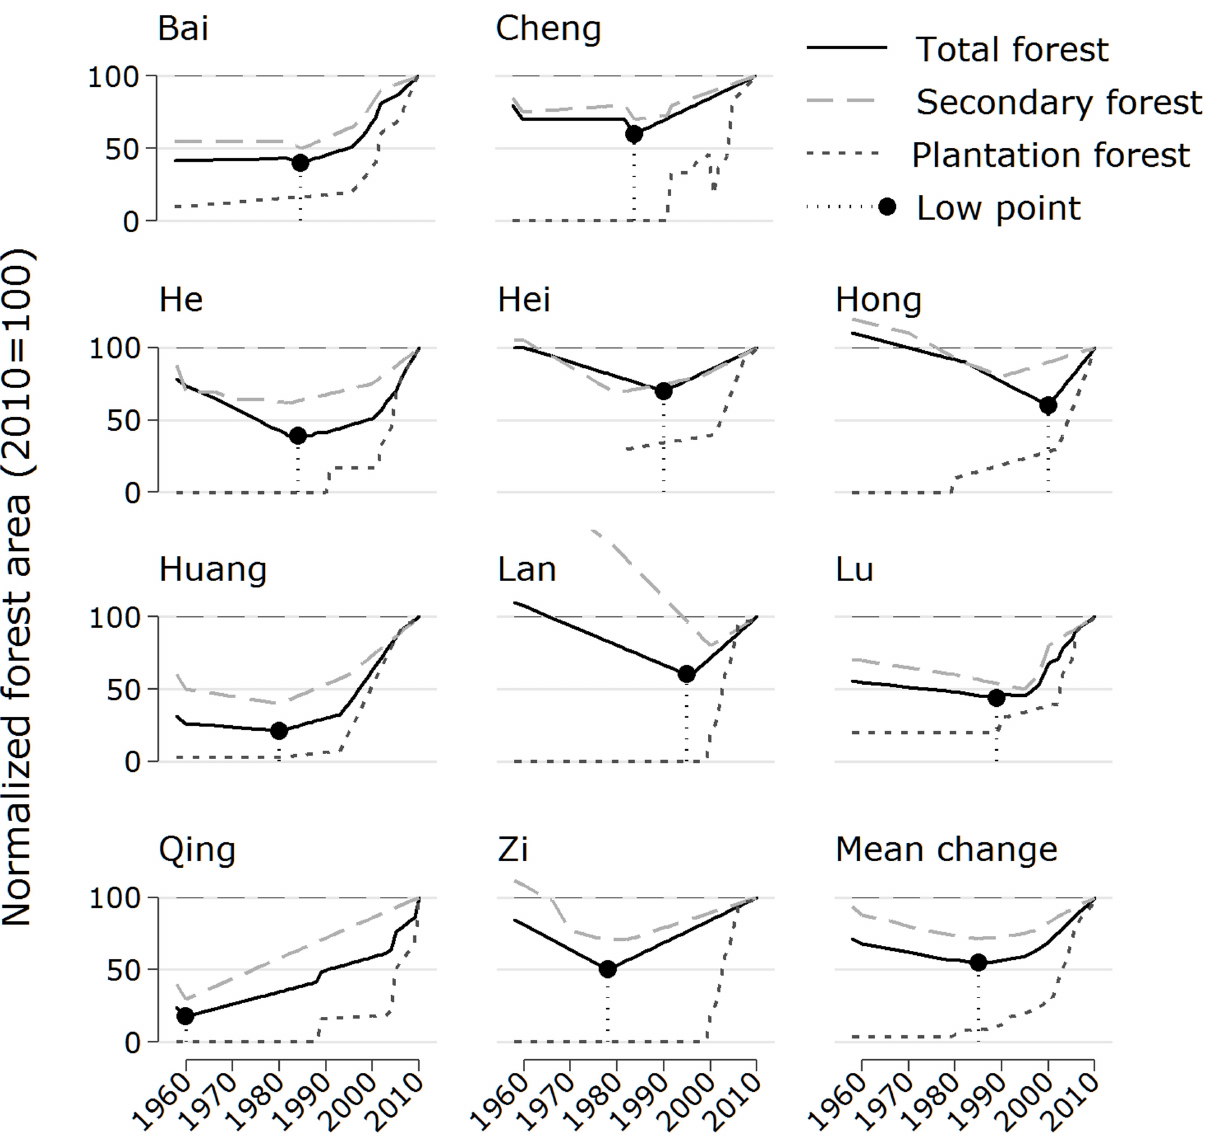
Figure 3. Historical forest-cover change at the village level (relative changes using 2010 as the reference year, for which all forest-cover categories were normalized to 100; see Section 3.2 for an explanation of the data